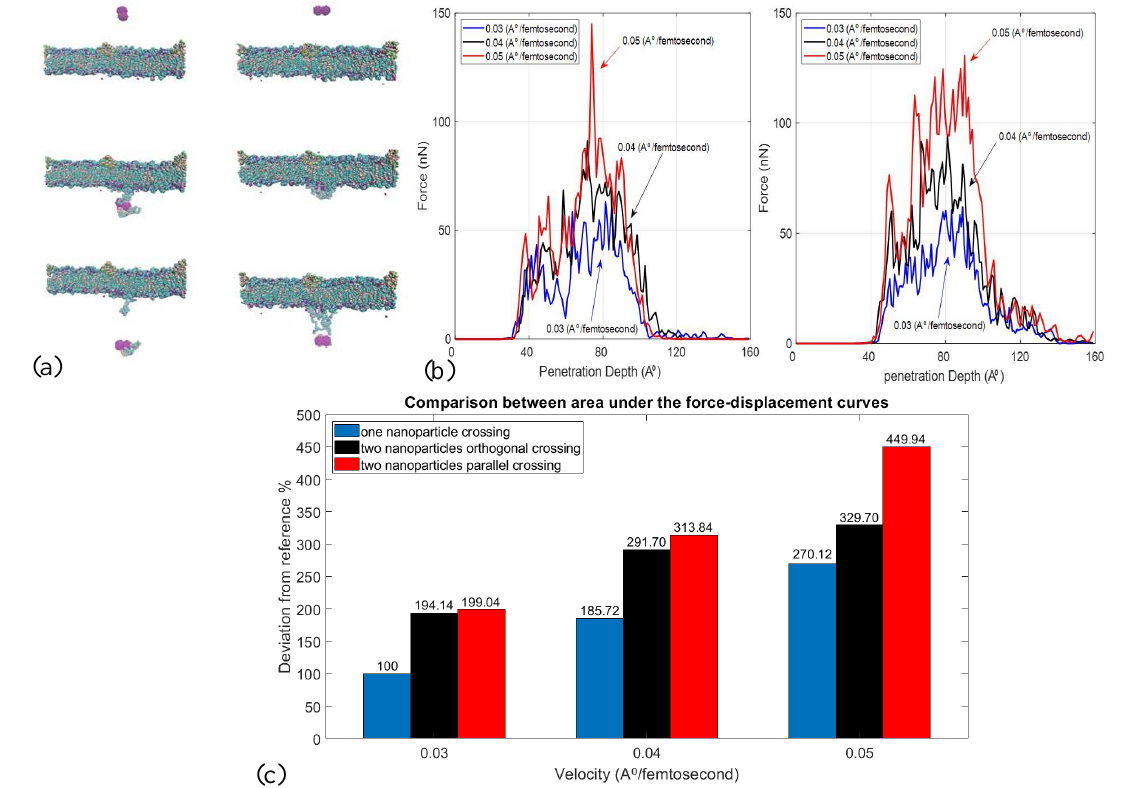
Figure 7. ( a ) Aggregated nanoparticles crossing the membrane in vertical and horizontal directions. ( b ) Force profiles applied by the membrane on the attached nanoparticles during the crossing with different velocities while being horizontal and vertical to the membrane. ( c ) Comparison between the required work (area under the force-displacement curve) for the crossing of a single nanoparticle with 0.03 A ◦ /femtosecond velocity as reference and other